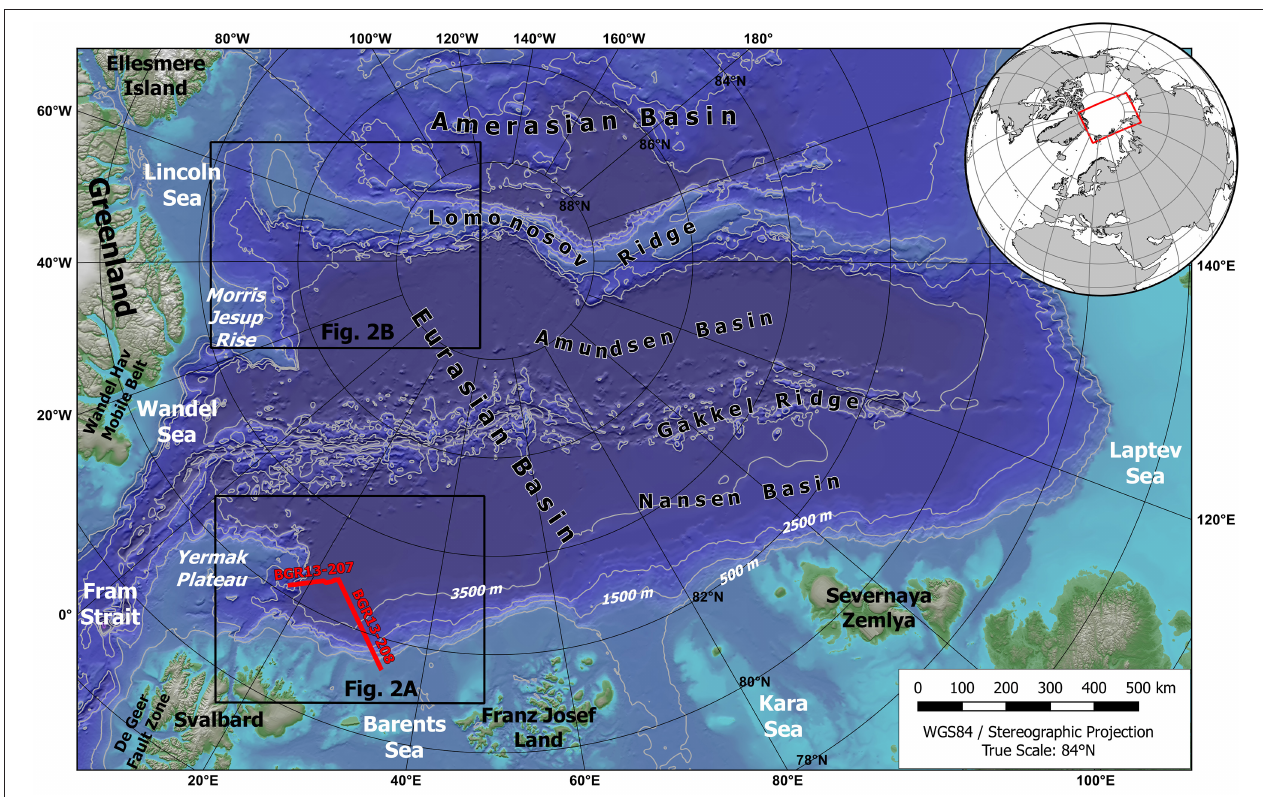
FIGURE 1 | The Eurasian Basin of the Arctic Ocean and surrounding areas. Red lines indicate the location the seismic sections shown in Figures 3 – 5 . The bathymetry is from the IBCAO dataset ( Jakobsson et al.,